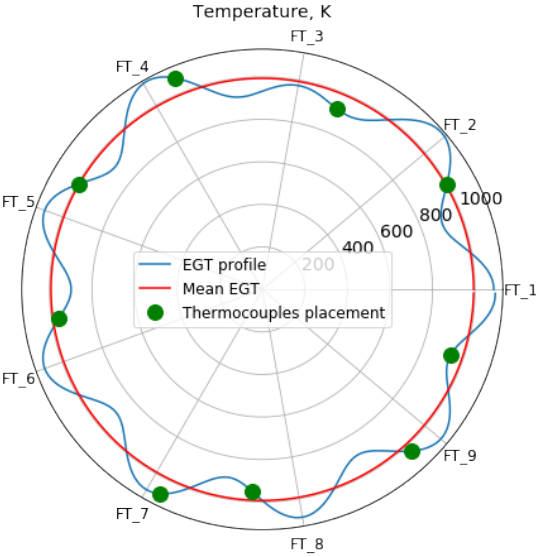
Figure 8. Temperature distribution after LPC turbine with a broken third flame